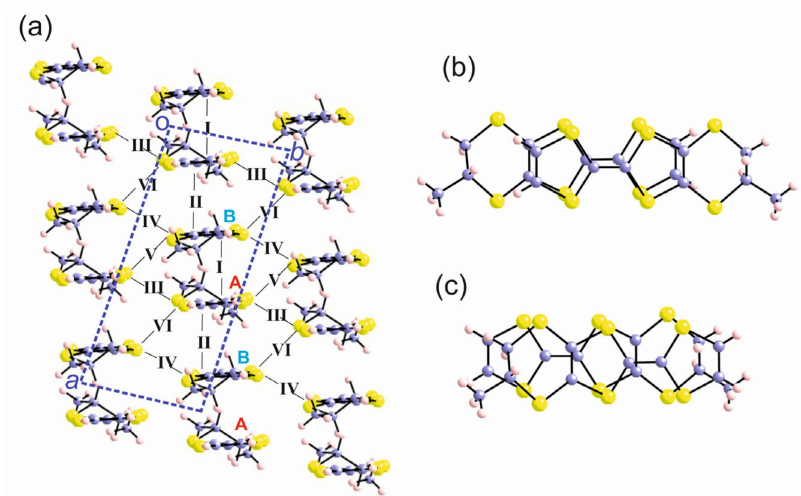
Figure 8. ( a ) Donor layer of the [( R )- 1 ] 2 ClO 4 salt where the di ff erent donors and intermolecular interactions are labeled; ( b ) Top view of the intra-dimer interaction I; ( c ) Top view of the inter-dimer interaction II. Table 5. Absolute values of the β HOMO-HOMO interaction energies (eV) for the di ff erent donor ···